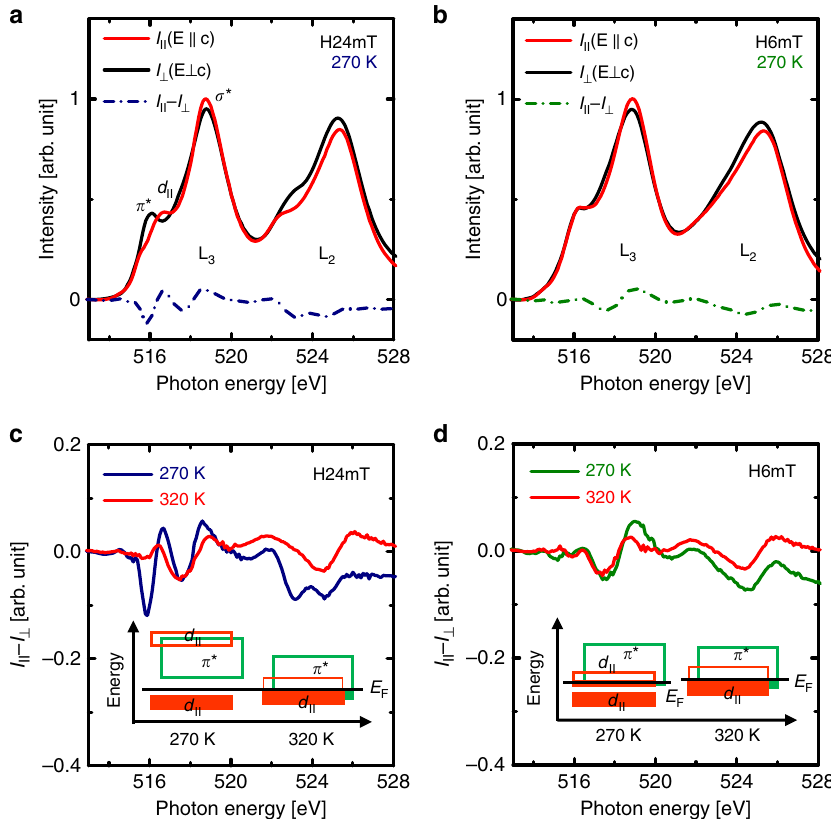
Fig. 4 Oxygen-vacancy-induced isotropic orbital occupancy in VO 2 templates. Polarization-dependent x-ray absorption spectroscopy (XAS) at the V L 2,3 - edges at 270 K for two heterostructures composed of 2.5-nm-thick TiO 2 fi lms grown on VO 2 templates under different pO 2 ( a H24mT, b H6mT). Unlike large difference of XAS signal in H24mT at 270 K due to the orbital polarization with V-V dimerization in the monoclinic VO 2 , almost no effect on the XAS signal in H6mT was observed at 270 K; this result indicates isotropic orbital fi lling in H6mT sample even at 270 K. The XLD ( I || – I ⊥ ) are also shown at both 270 K and 320 K for c H24mT and d H6mT. Oxygen vacancies driven by directional ionic transport in H6mT tend to increase the crystal symmetry to close to rutile structure by weakening of V-V dimerization, so selective fi lling of d || (inset of c .) changes to isotropic orbital occupancy of d || and π * (inset of d ) in VO 2 templates; the oxygen-vacancy-driven isotropic occupancy leads to metallization at 270